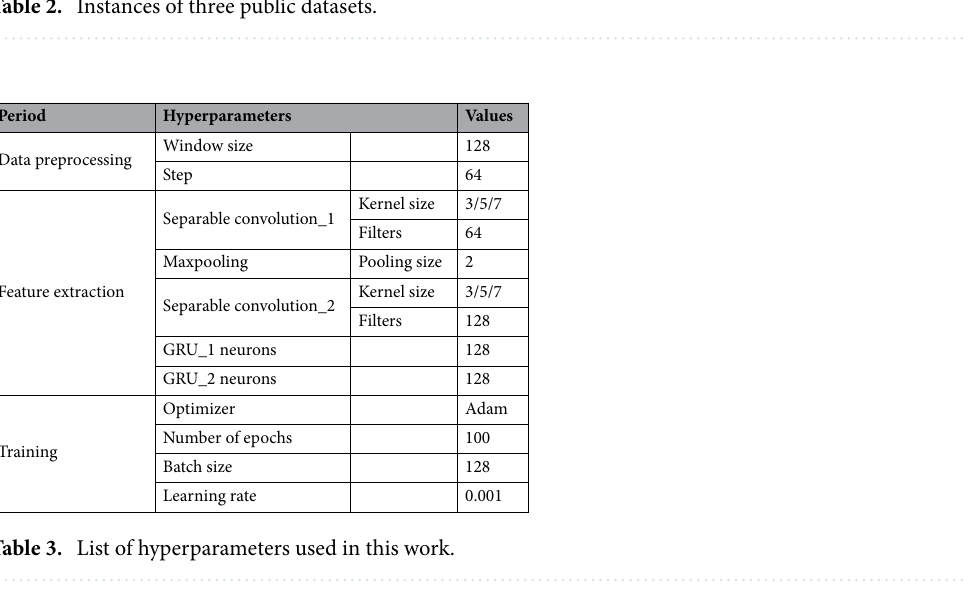
Table 2. Instances of three public datasets.